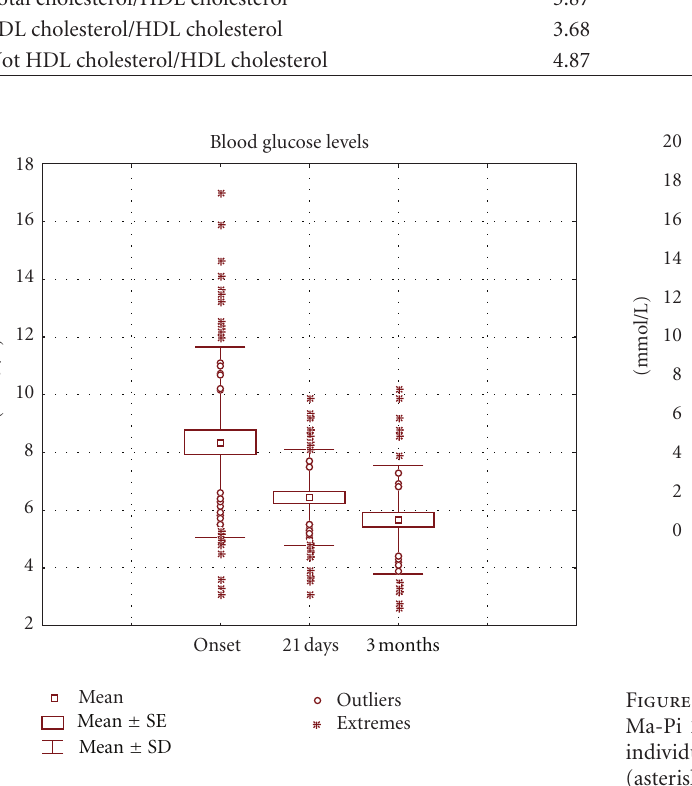
Figure 1: Evolution of the serum glucose levels of type 2 diabetic adults with Ma-Pi 2 diet. Note: the figure shows the mean values (squares), individual distant values (circles), and individual extreme values (asterisks) at 3 times of the assay: at onset, 21 days and 3 months after intervention with the assayed diet. The mustaches represent the standard deviation and the biggest squares the standard error of the mean. Values are expressed in mmol/L.